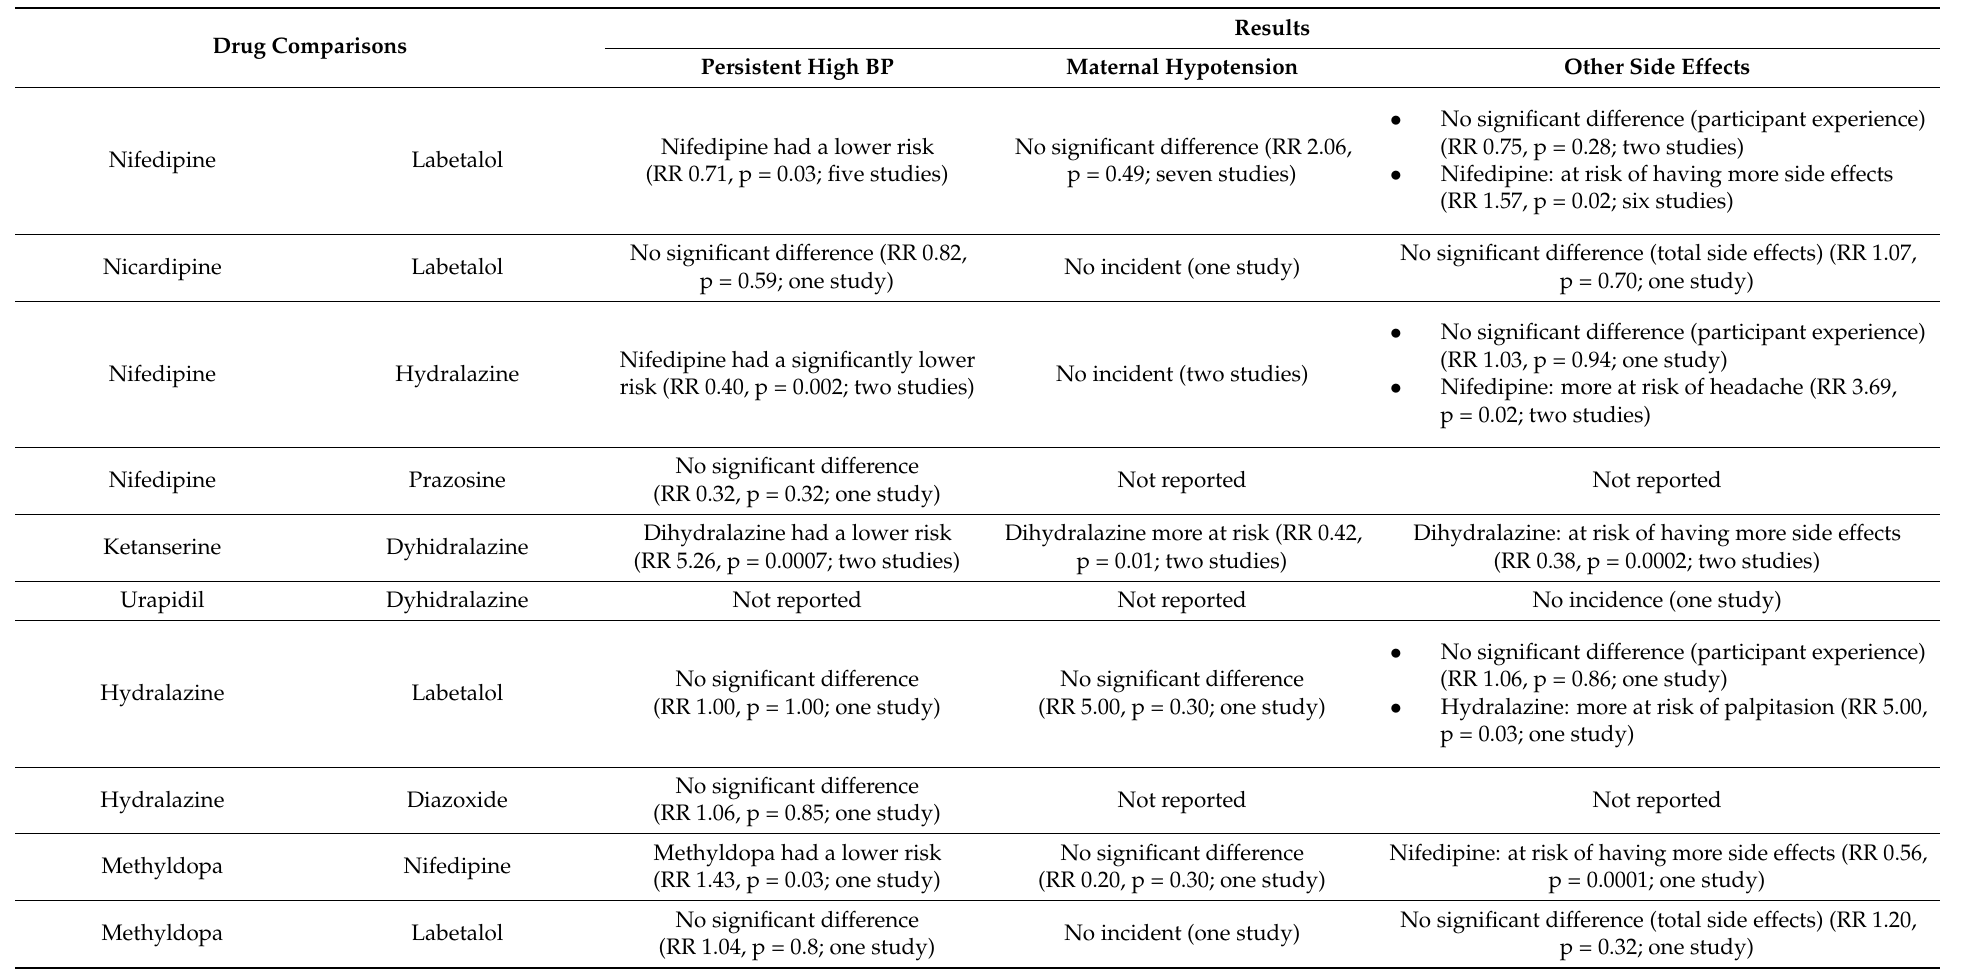
Table 5. Summary of intervention